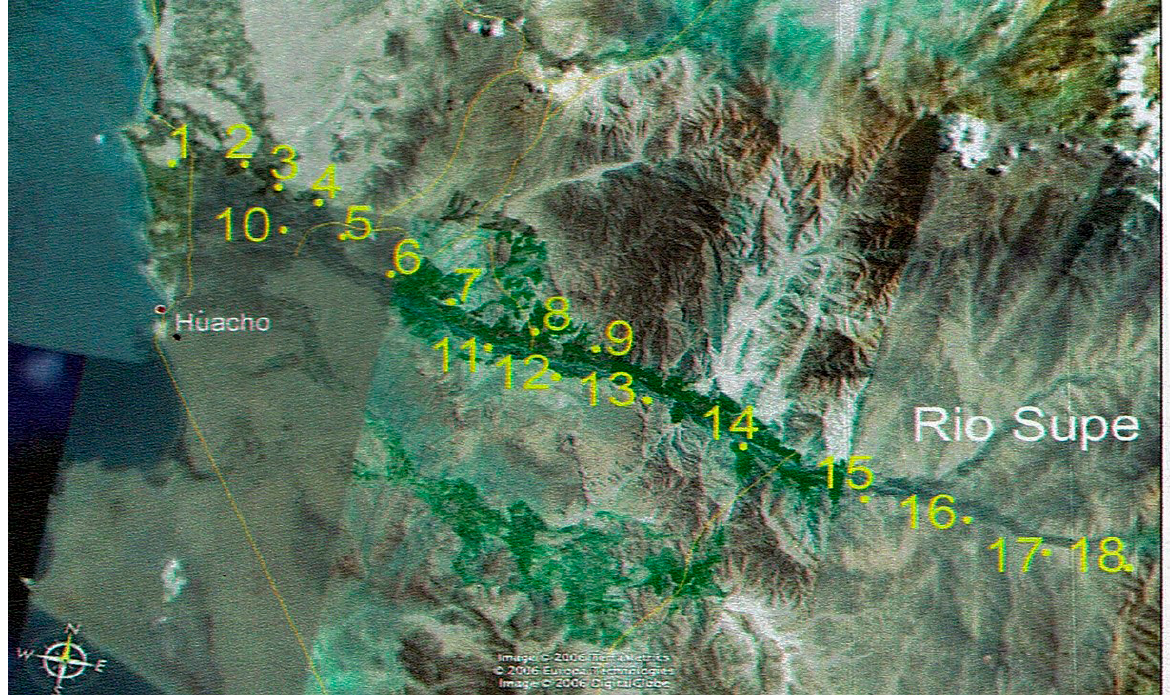
Figure 4. Site locations in the Supe Valley along the Rio Supe (site names given in Appendix A). The site of Áspero is located on a coastal prominence west of Site 1. Length scale from Site 1 to site 18 is ~80 km.